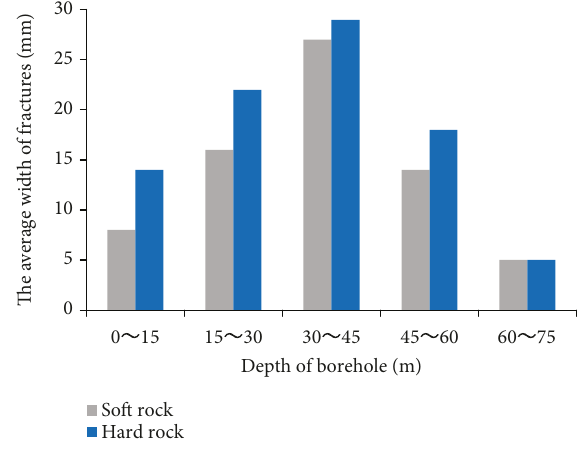
Figure 14: Histograms of the average fracture width of soft and hard rocks with di ff erent borehole depths. Table 6: Empirical formula from “ three down ” procedure